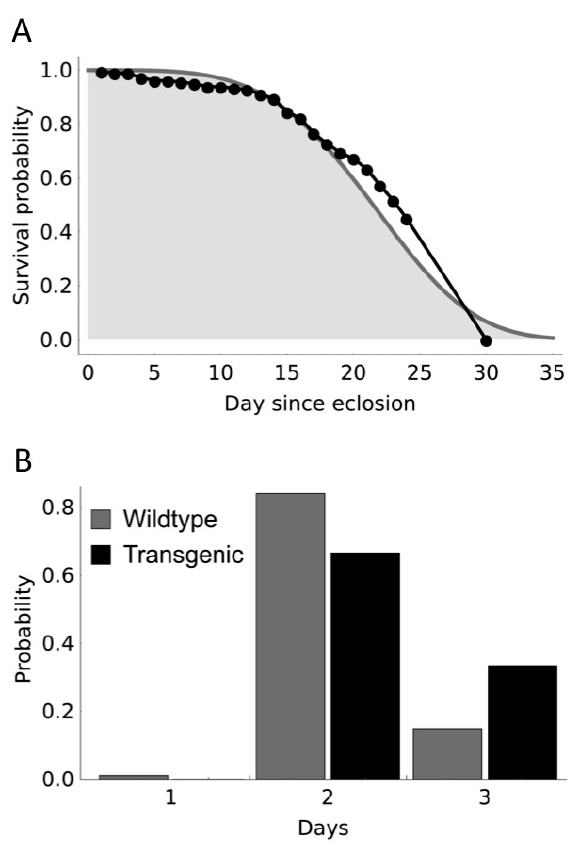
Figure 1. Adult longevity and duration of pupation used for the model. ( A ) illustrates adult longevity data (black markers) of [23] that was used to fit a Weibull curve for survival (solid line delimiting gray area fitted by maximizing likelihood). In addition to the data which was available for 24 days, we assumed all adults died before day 30; and ( B ) the distribution of pupal development times used for model parameterization is shown, based on summarized data [22].